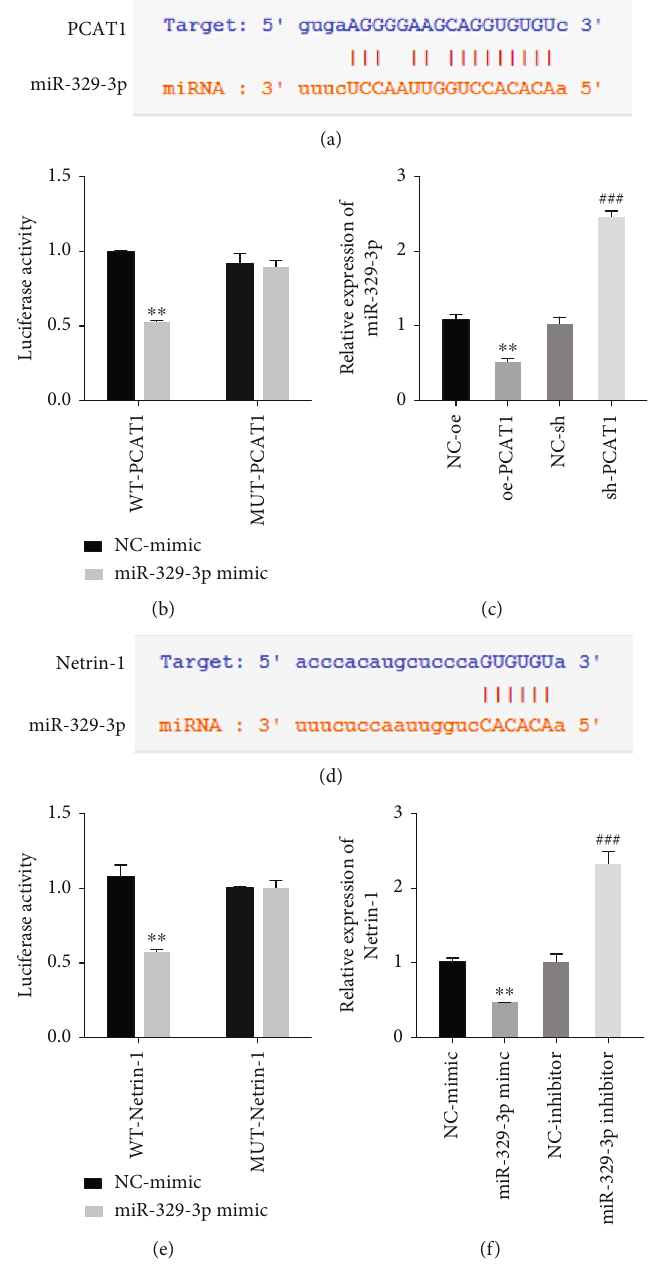
Figure 4: Identi fi cation of targeted regulatory relationships. (a) The StarBase website predicts the targeted sites. (b) The dual luciferase gene report experiment. ∗∗ P < 0 : 01 vs NC-mimic. (c) The expression of miR-329-3p was detected by RT-qPCR. ∗∗ P < 0 : 01 vs NC-oe; ### P < 0 : 001 vs NC-sh. (d) The StarBase website predicts the targeted sites. (e) The dual luciferase gene report experiment. ∗∗ P < 0 : 01 vs NC- mimic. (f) The expression of Netrin-1 was detected by RT-qPCR. ∗∗ P < 0 : 01 vs NC-mimic; ### P < 0 : 001 vs NC-inhibitor,